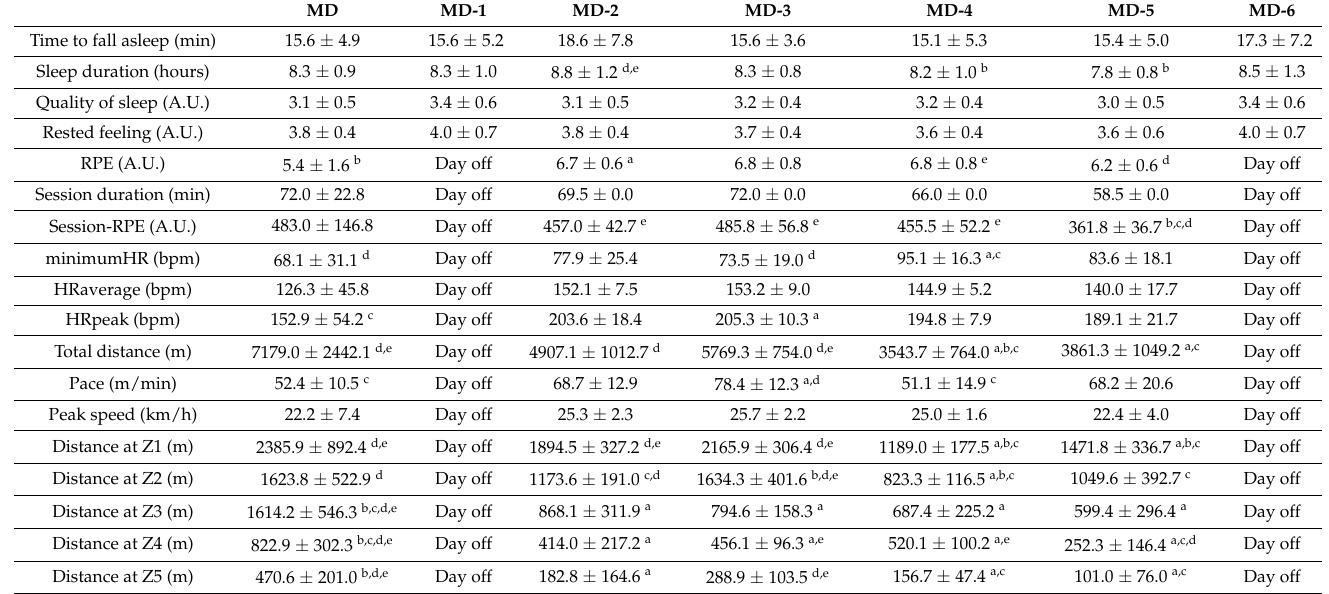
Table 3. Descriptive statistics (mean ± standard deviation) of sleep and training demands over the